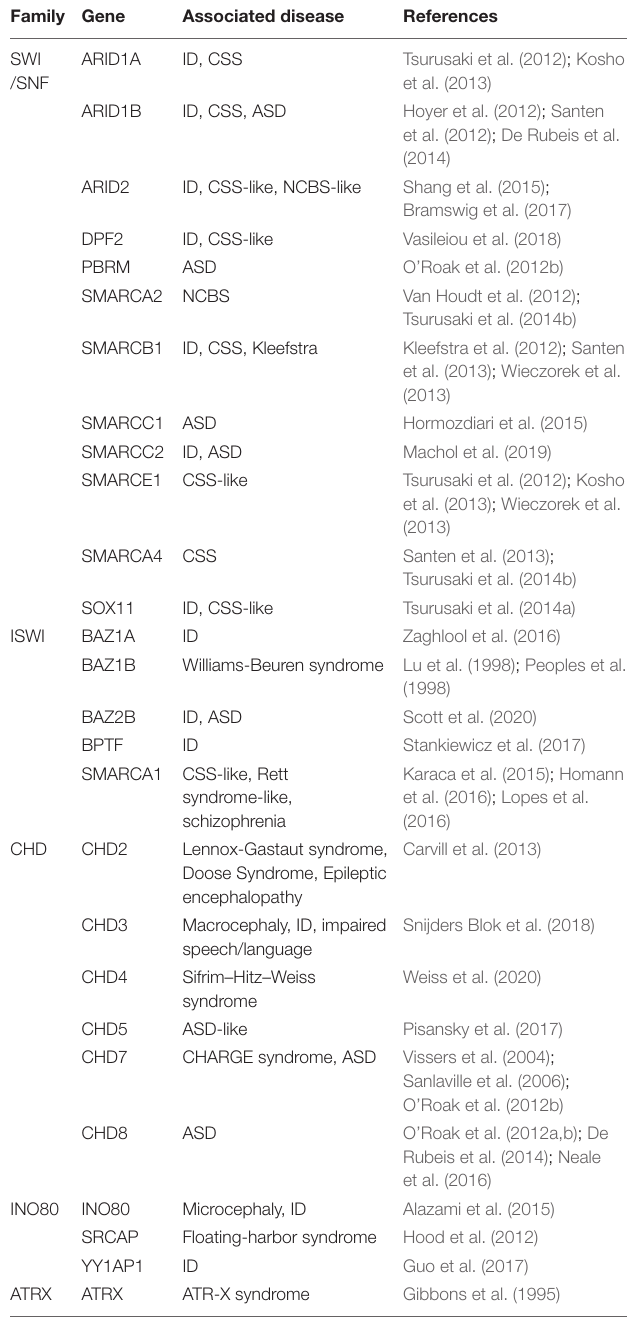
TABLE 1 | ATP-dependent chromatin remodelers are a frequent cause of NDDs. List of NDD implicated genes which are incorporated into ATP-dependent chromatin remodeling